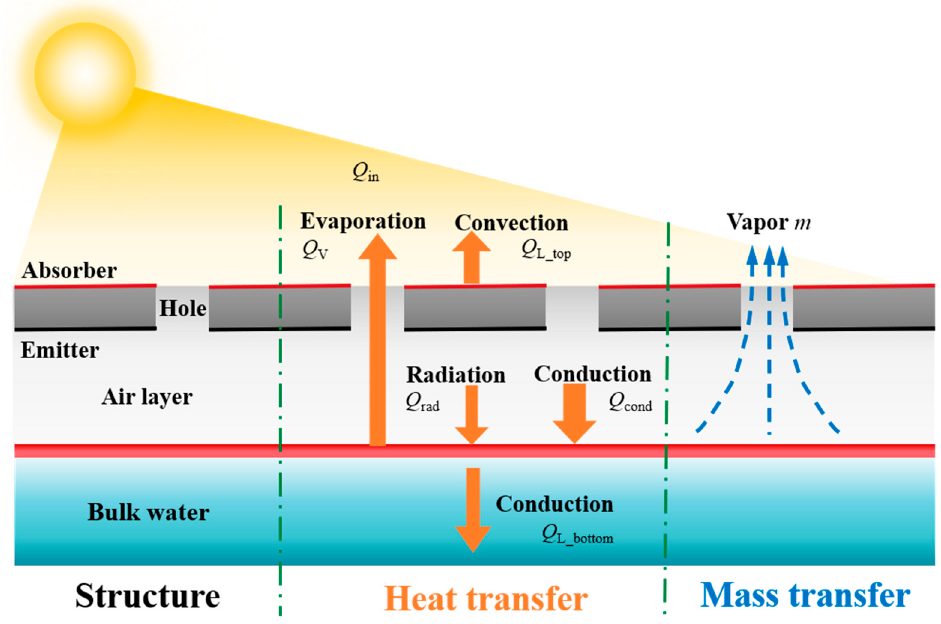
Figure 1. Schematic of the SCE. The red region in bulk water represents the penetration depth of infrared thermal radiation (~10 μ m).